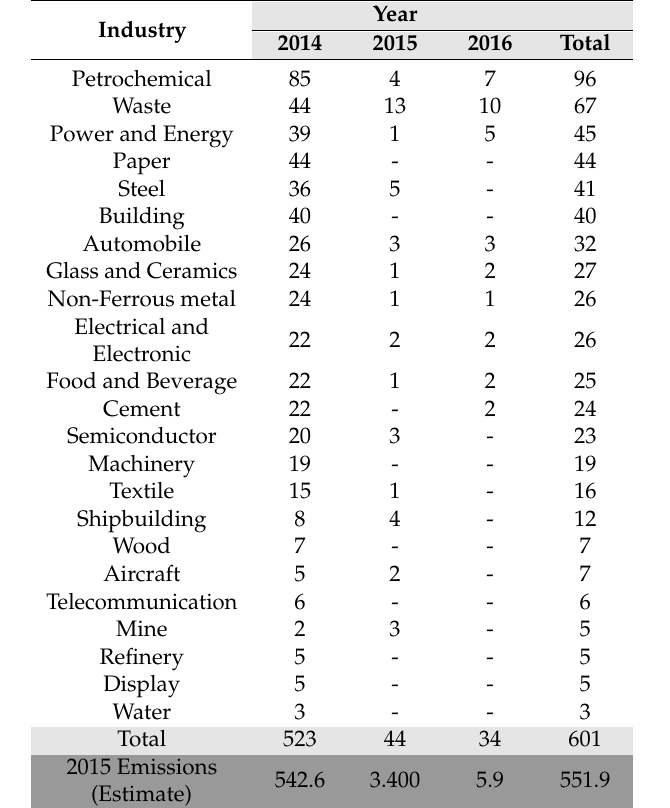
Table 2. Newly regulated emissions under ETS during